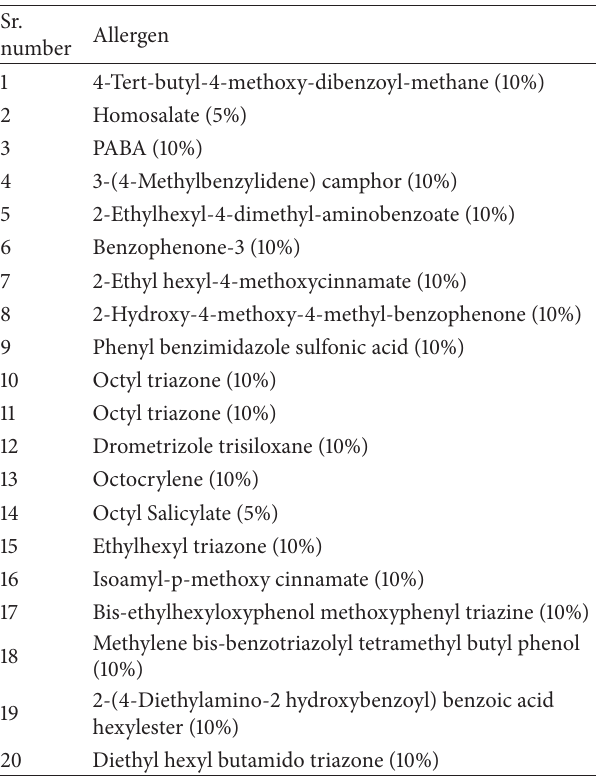
Table 2: Indian Sunscreen Series ∗ .